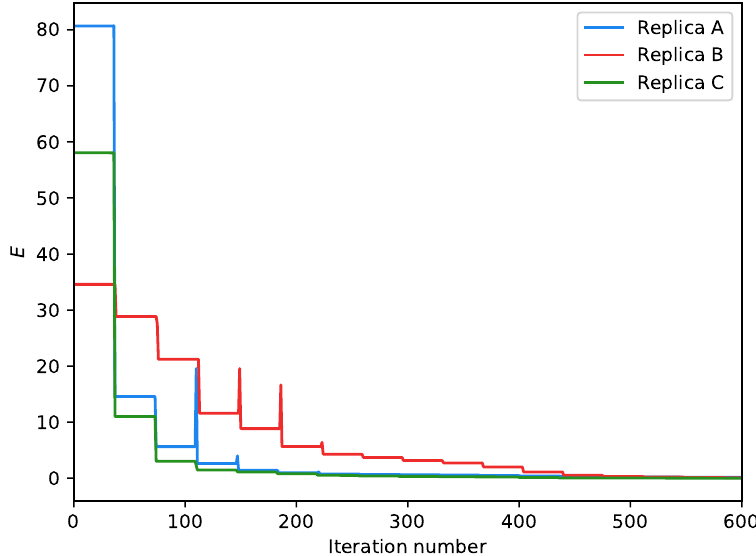
Figure 4 . The error function E for L0 closure tests based on the SM scenario as a function of the number of iterations. We show the results for three (cid:12)ts to the same pseudo-data but with di(cid:11)erent initial boundary